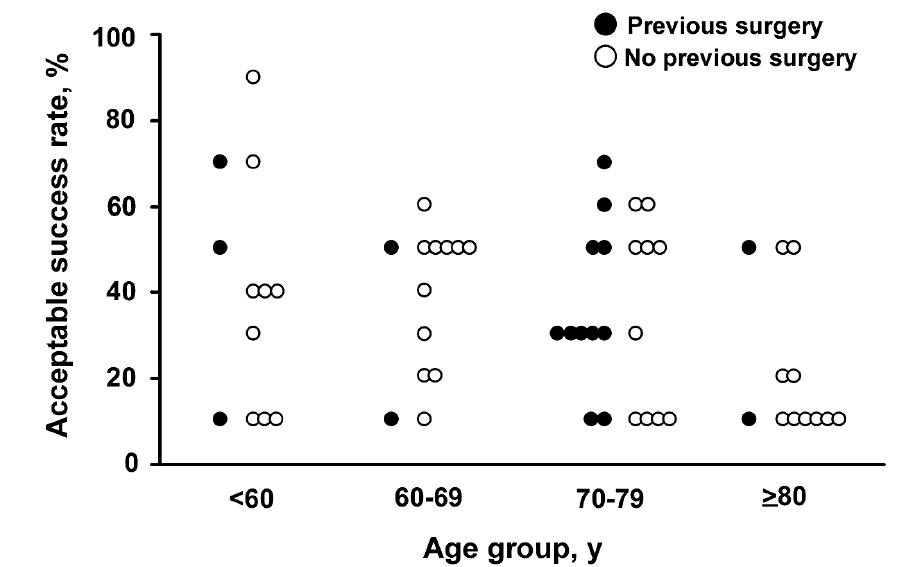
Figure 1 – Patients’ lowest acceptable success rates for injectable therapy among 58 patients with or without a history of previous urogynecologic surgery. The patients provided these rates in response to an initial interview question during evaluation for urinary